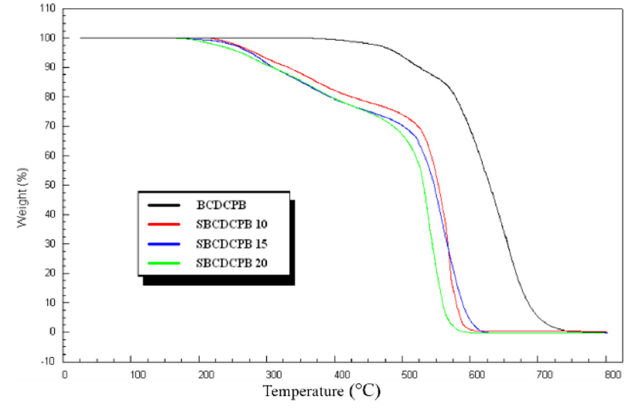
Figure 2. Thermooxidative stabilities of the sulfonated polymer membranes.